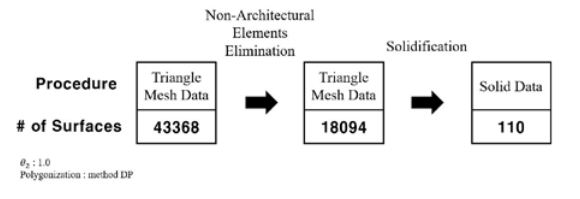
Figure 13. Surfaces number according to process